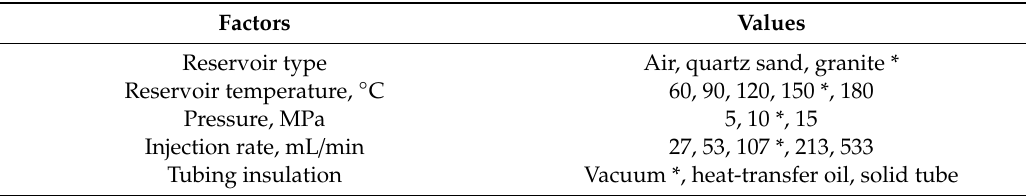
Table 2. Experimental schemes of the heat exchange tube to simulate wellbore self ‐ circulation.